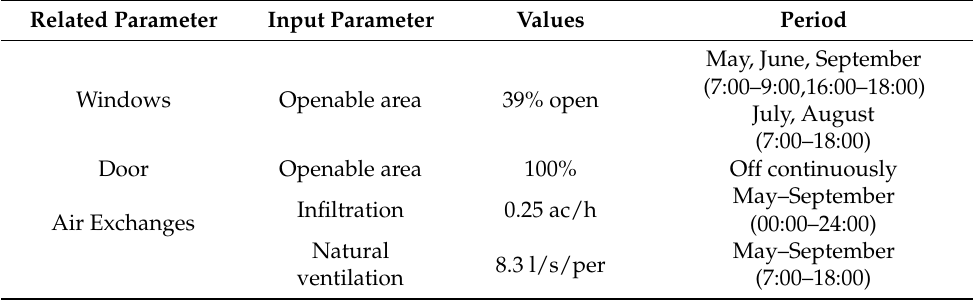
Table 9. Ventilation parameters for the model.